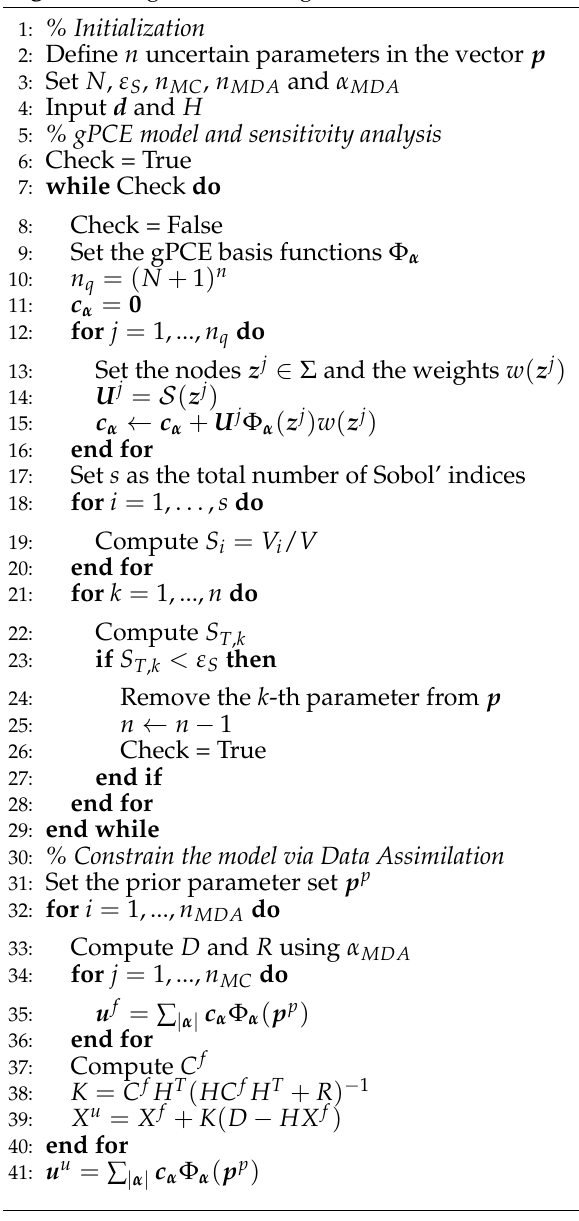
Algorithm 1 gPCE-ES and gPCE-MDA for the forward model S